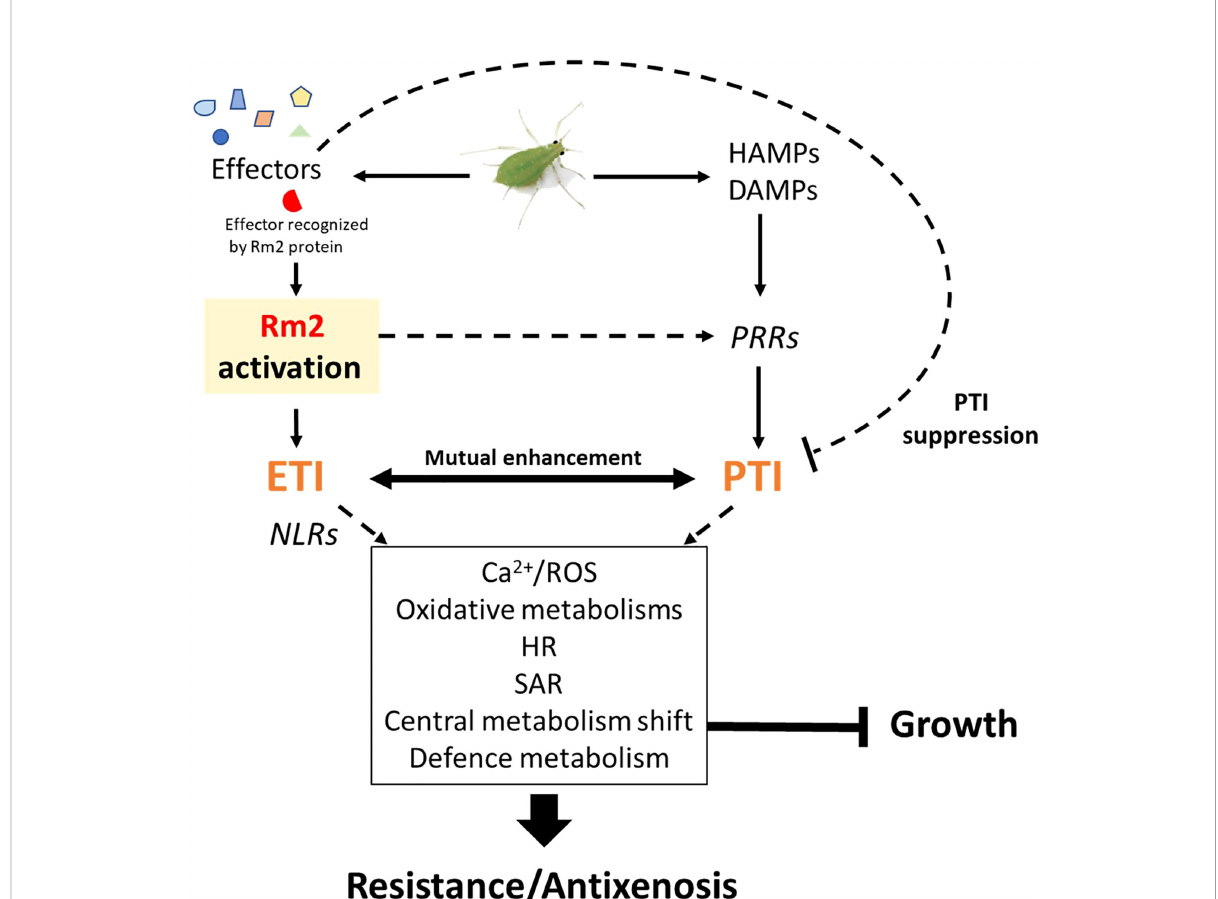
FIGURE 9 Conceptual model of the immune response to aphids in Rubira apices. Activation of the NLR receptor protein Rm2 by one of the M. persicae effectors triggers the transcription of numerous ETI and PTI genes as well as SAR and HR markers, resulting in metabolic recon fi gurations favoring defense at the expense of growth: activation of H 2 O 2 -producing metabolic pathways, depletion of central metabolite pools and accumulation of caffeic acid